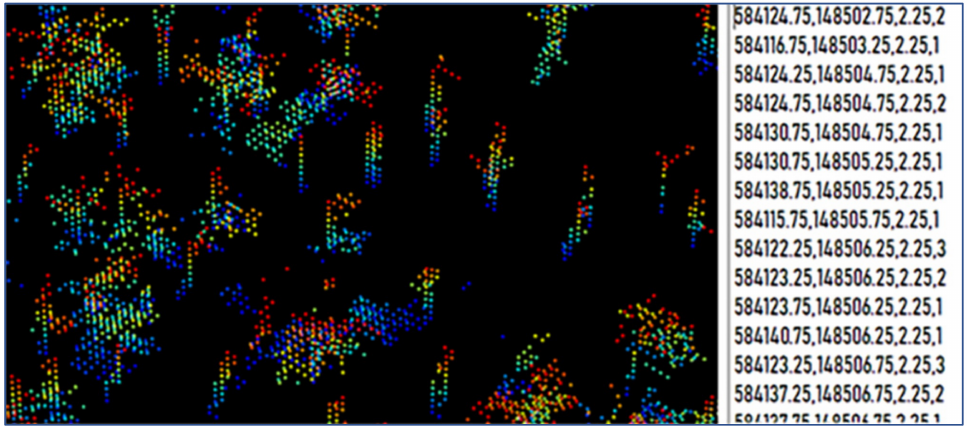
Figure 8. Portion of a voxelized point cloud ( left ) with visible voxel columns and a sample of the raw voxel data containing coordinates, vertical height increment and number of points in that voxel ( right